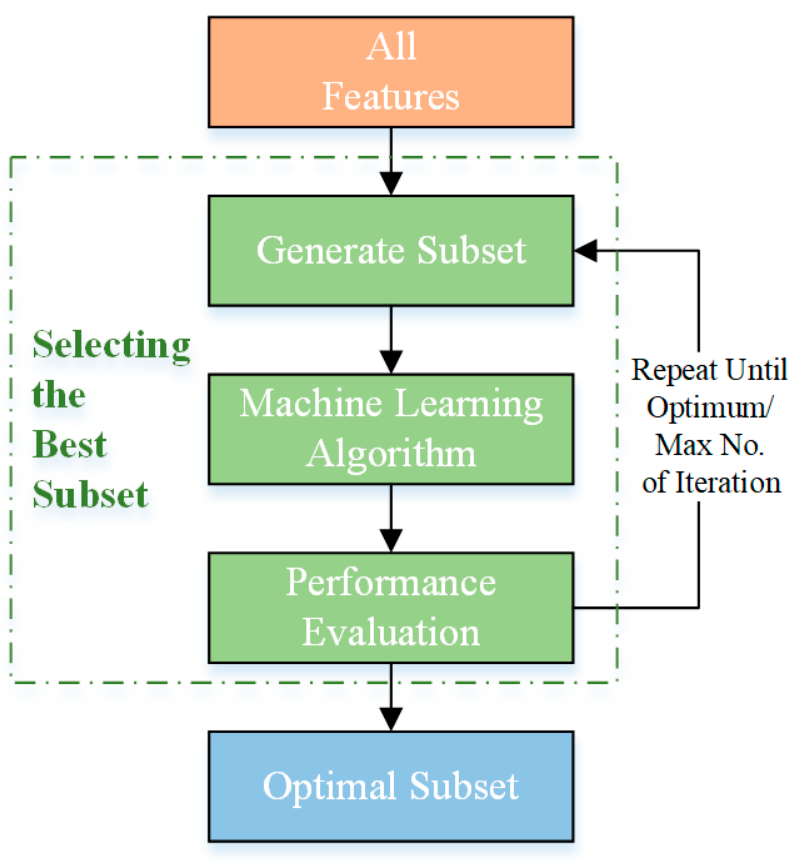
Figure 2. Working flow for the wrapper-based approach. The goal of metaheuristic techniques is to estimate the solutions to complex